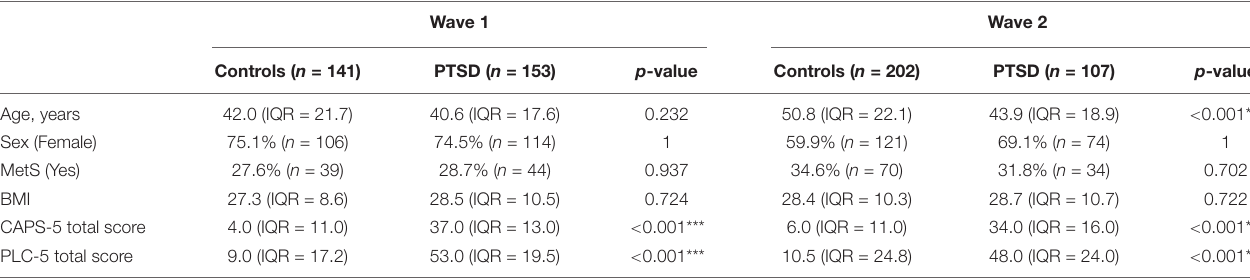
TABLE 1 | Descriptive characteristics of Wave 1 and Wave 2 participants.